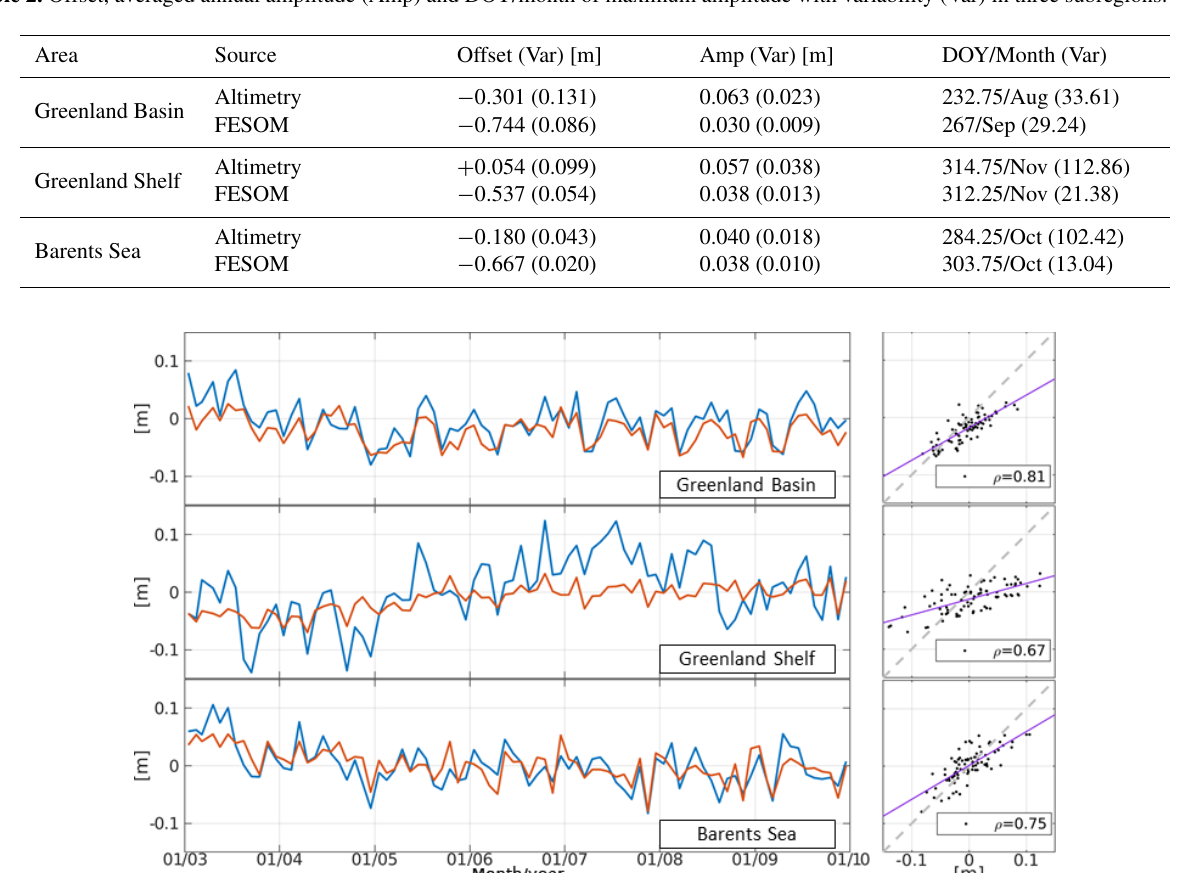
Figure 7. Monthly time series of averaged residual heights from altimetry (blue) and FESOM (red). Offsets and annual signals were removed for each region. Additionally, scatter plots and correlation ( ρ ) are displayed. Regression and bisectrix lines are shown by the purple and dashed gray lines,